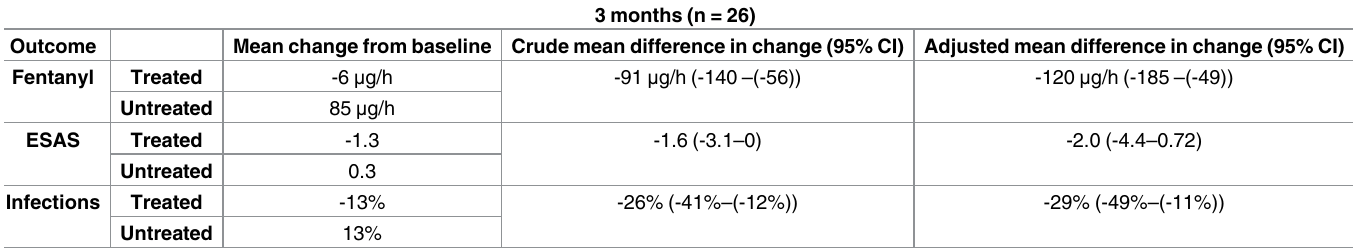
Table 3. Results from crude and adjusted analysis of change in fentanyl dose, ESAS QoL-score and infections (% days with antibiotics) compared to baseline in vitamin D treated and untreated patient after 3 month. Figures show mean value (95%